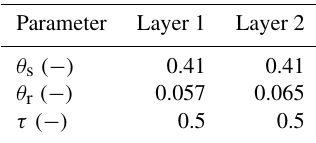
Table 2. Fixed Mualem–van Genuchten